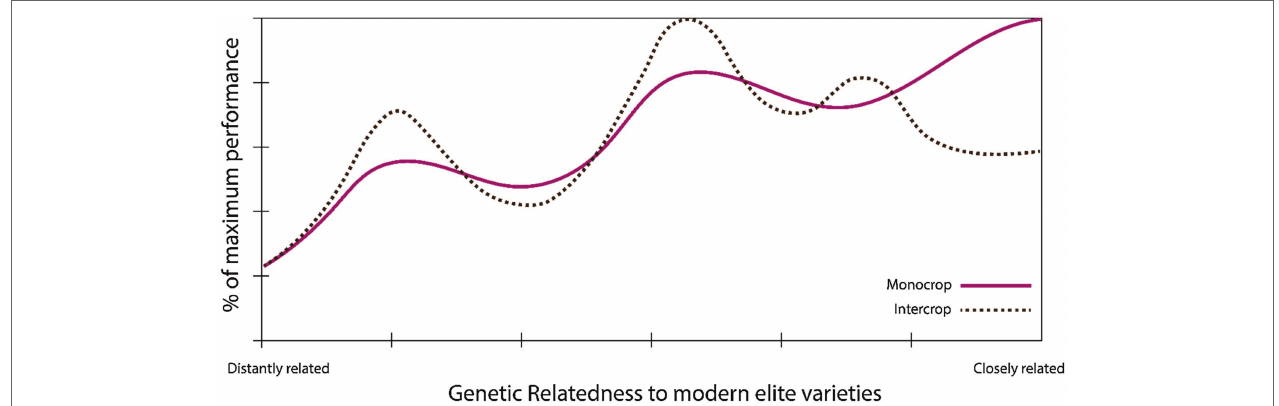
FIGURE 3 | Theoretical performance landscape of modern varieties for intercropping. Modern elite varieties may not be optimal for intercropping, due, for example, to reduced partitioning of assimilates to seeds or reduced biodiversity effects when grown in mixtures (Chacón-Labella et al., 2019; Chen et al., 2021). Breeding efforts may have to break through local optima (dashed line) by accessing wider pools of genetic diversity in order to re-equip crops with features suited to